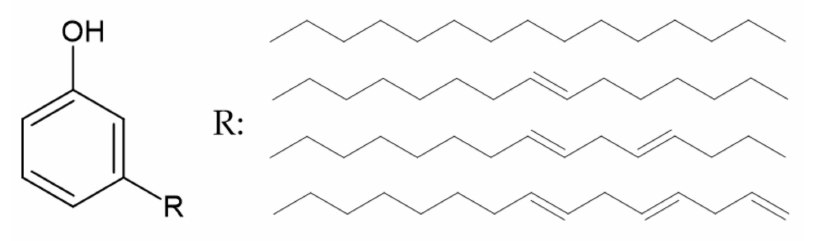
Figure 8. The structure of cardanol [36].